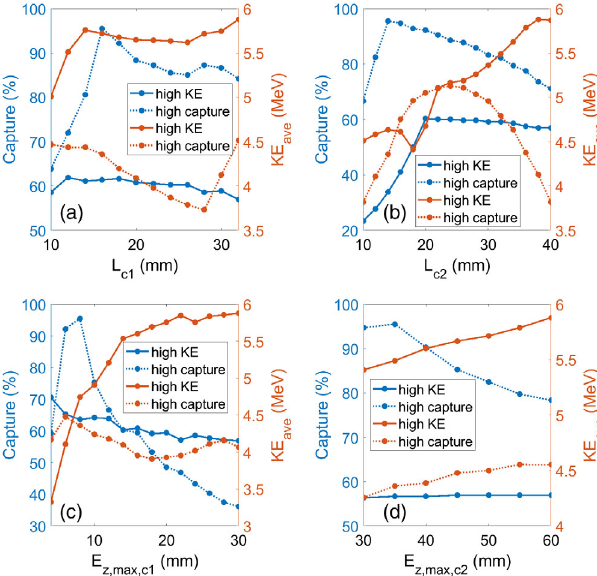
FIG. 8. Applegate diagram generated with the optimized field profile of Fig. 7.